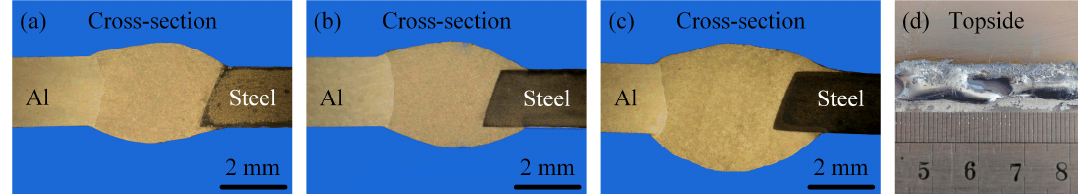
Figure 3. Effects of wire feeding speed on the weld shape: ( a ) 4.0 m/min; ( b ) 4.5 m/min; ( c ) 5.0 m/min; ( d ) 5.5 m/min.